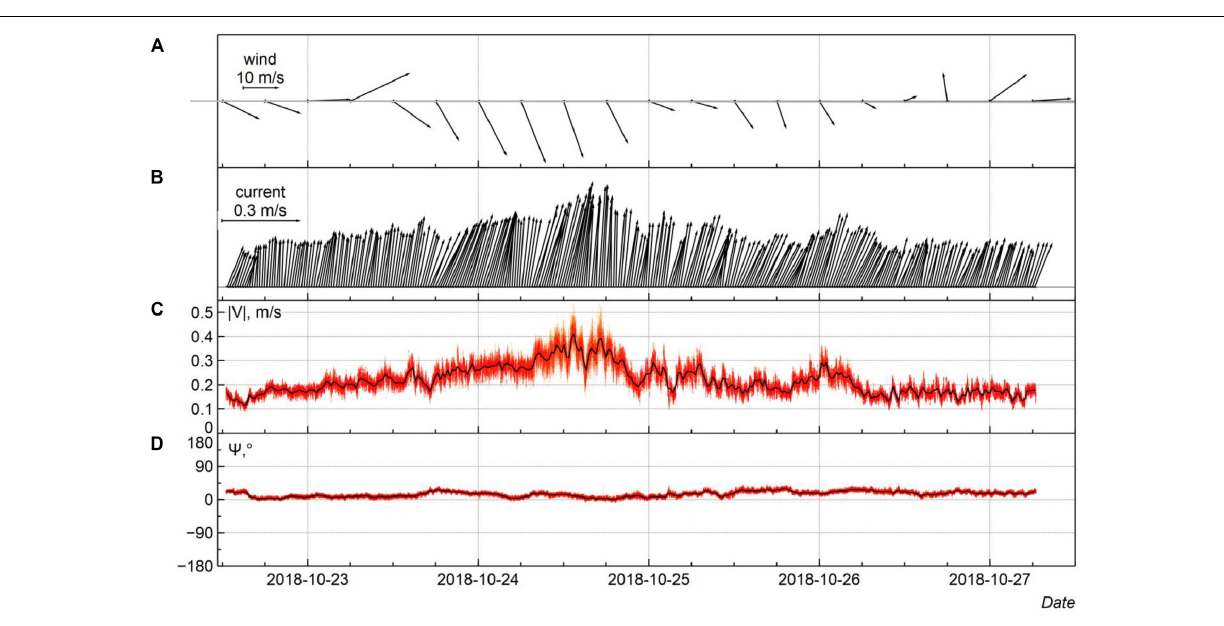
Frontiers in Earth Science |